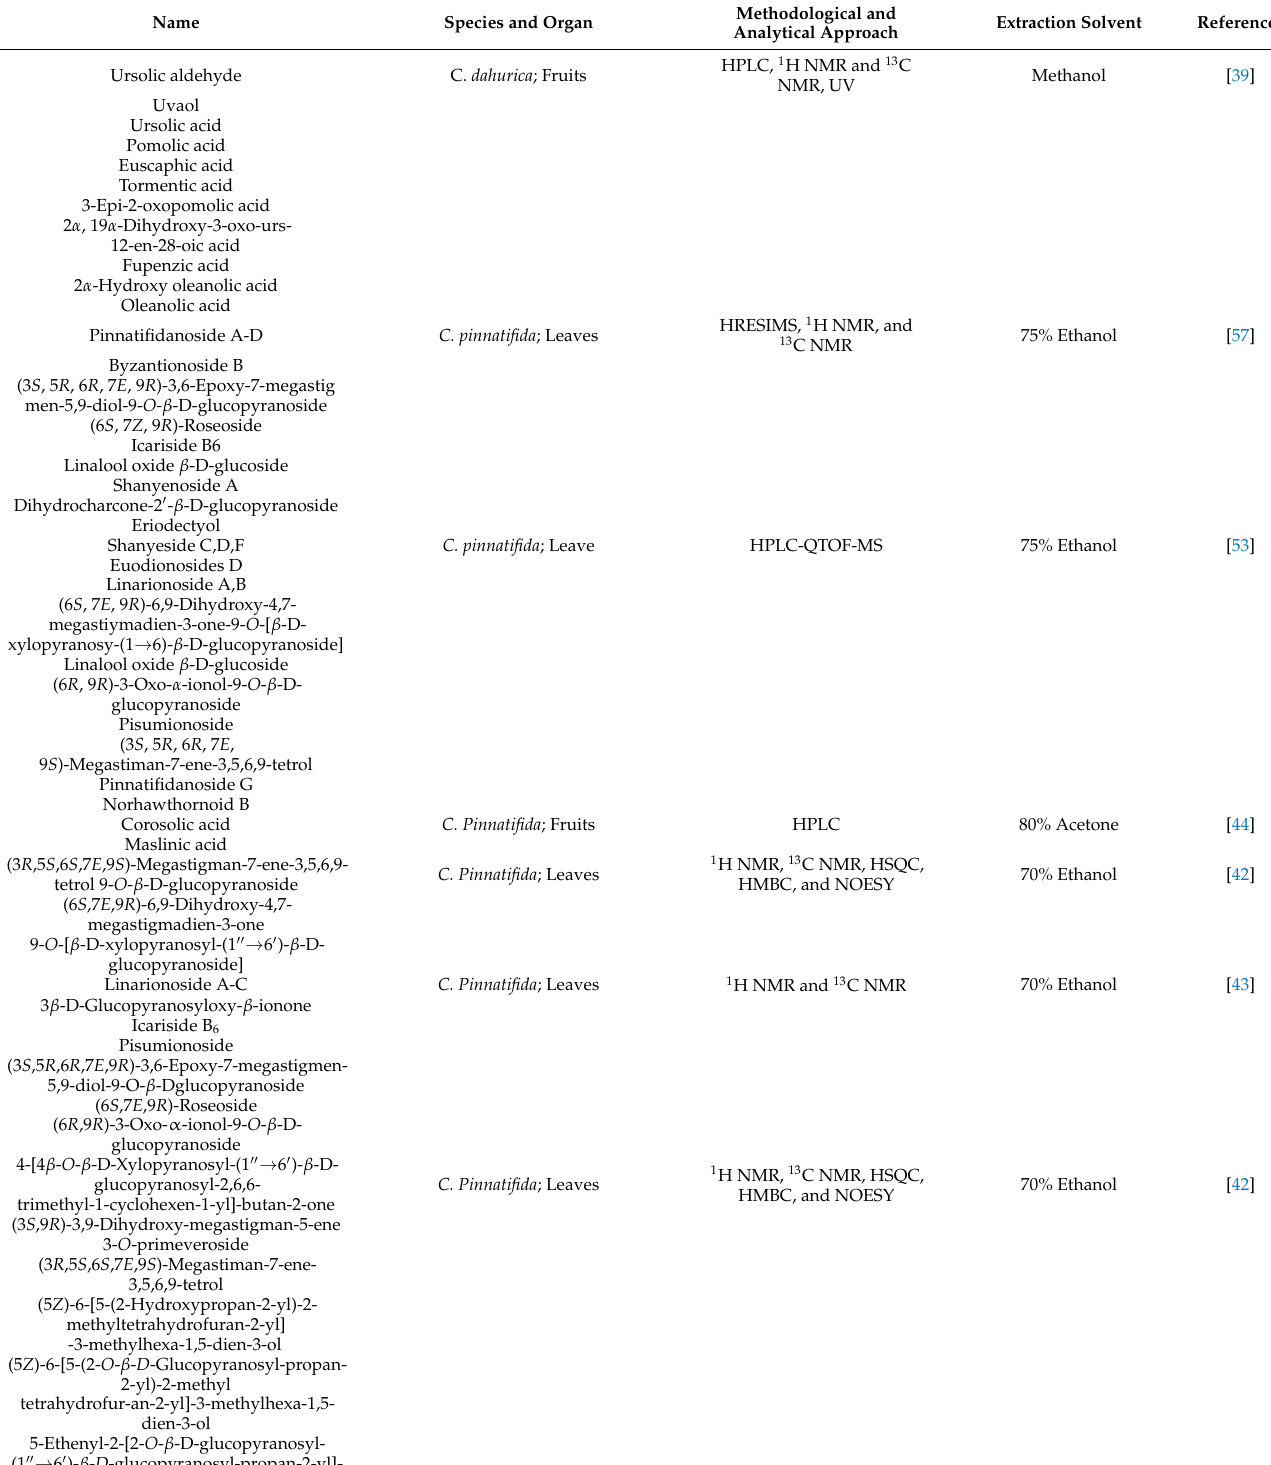
Table 3. Terpenoids identified from